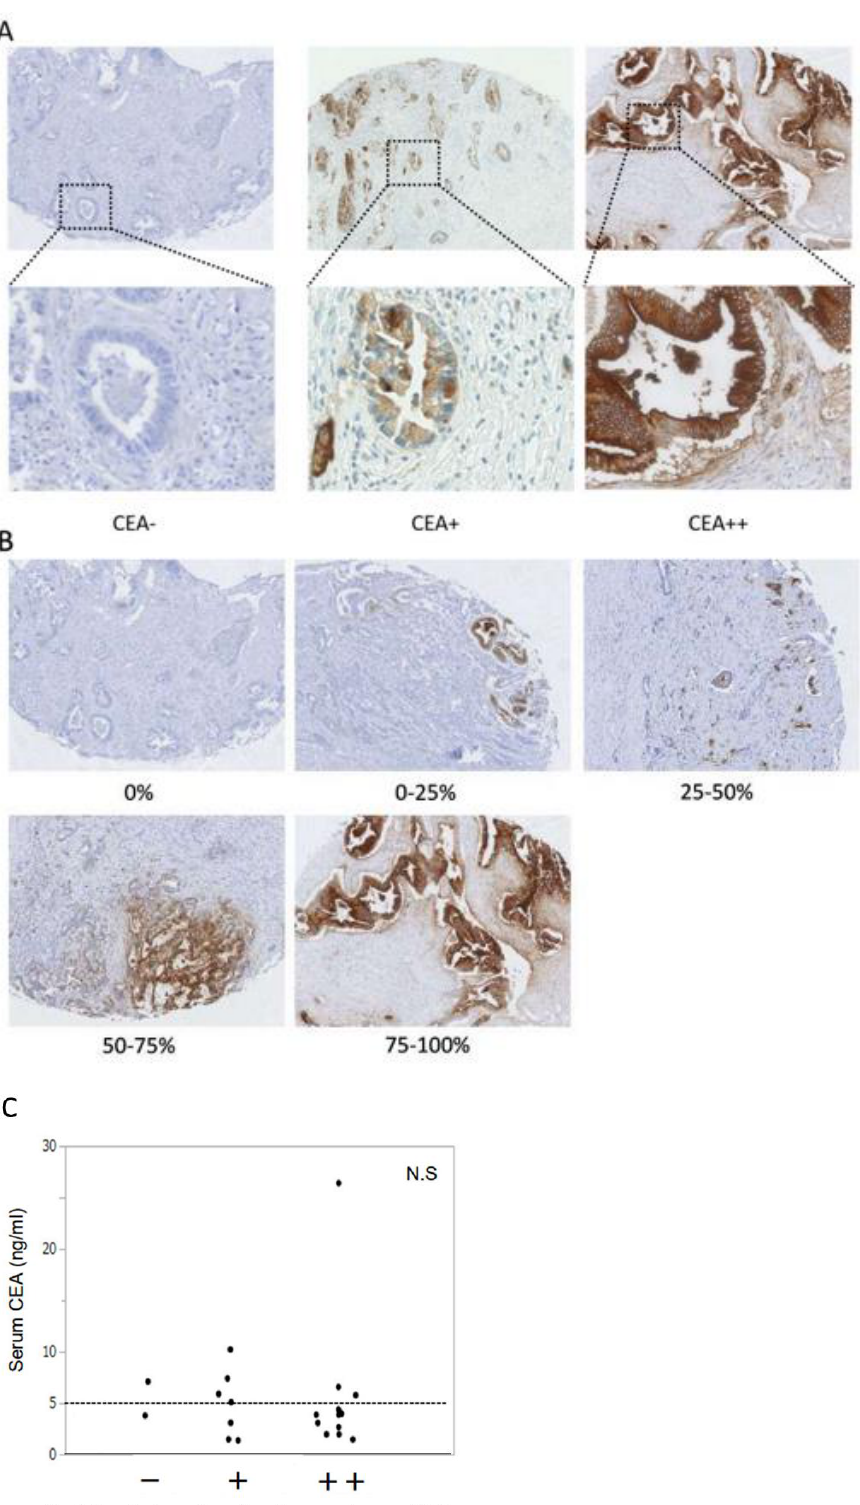
Figure 8. Immunohistochemical staining for CEA in PDAC patients. ( A ) CEA staining intensity was categorized into three grades. ( B ) Heterogeneity was classified into five grades. ( C ) Analysis of correlation between serum CEA and staining intensity of cell membrane CEA. There was no significant